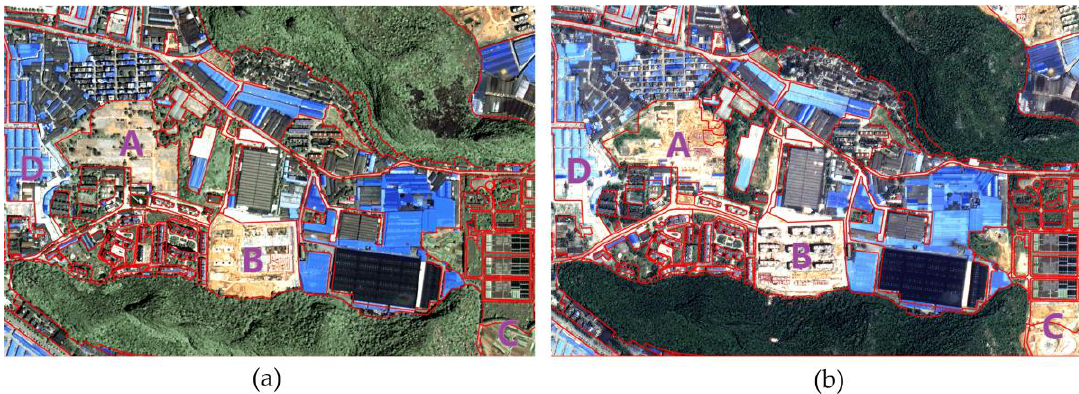
Figure 1. Examples of global and local change with regard to the polygons in an HVM. ( a ) T1 image overlaid with an HVM; ( b ) T2 image overlaid with an HVM.